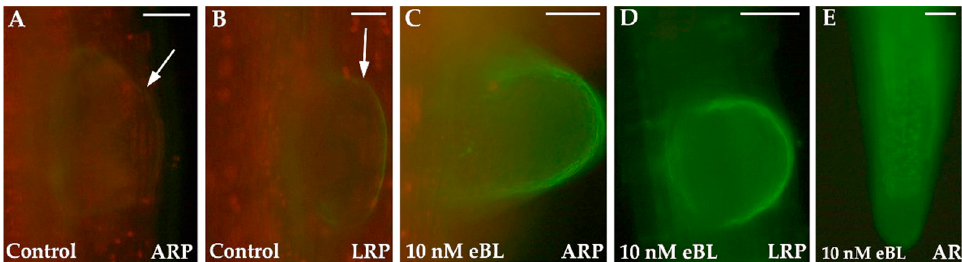
Figure 2. Adventitious root primordia (ARPs) ( A , C ), lateral root primordia (LRPs) ( B , D ), and apices of adventitious roots (ARs) ( E ) of Arabidopsis thaliana seedlings grown for 16 days in the absence (Control, ( A , B )) or in the presence of 10 nM 24-epibrassinolide (eBL) ( C – E ) and then treated with the NO-specific probe 4-Amino-5-Methylamino-2’,7’-Difluorofluorescein Diacetate (DAF-FM DA). The fluorescence signal was visualized using a DMRB microscope (Leica, Wetzlar, Germany). Arrows show the inception of the dome of an ARP ( A ) and of an LRP ( B ). Bars: ( A , C – E ) = 40 µ m; ( B ) = 20 µ m. Data from Della Rovere et al.